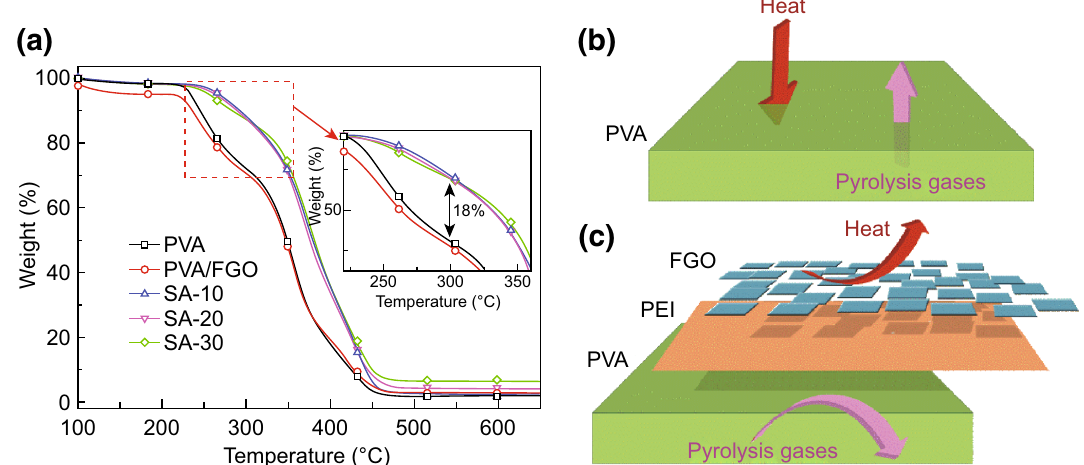
Fig. 6 a TGA profiles of neat PVA, PVA/FGO, and PVA coated with different FGO-based layers. Schematic depicting degradation processes of b pure PVA and c coated PVA